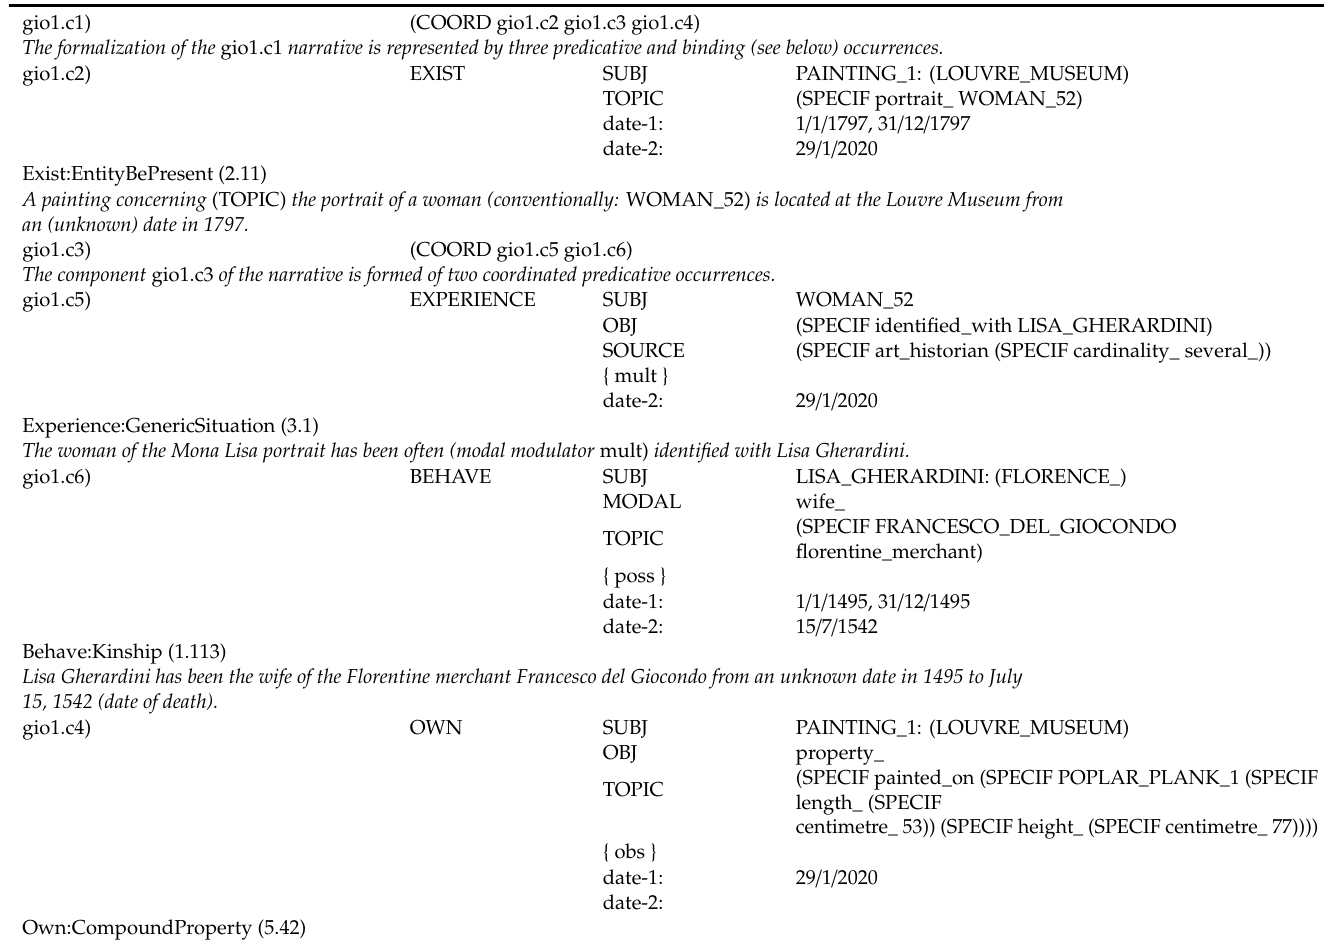
Table 1. Formalization of basic information about the Mona Lisa picture under the form of a simple